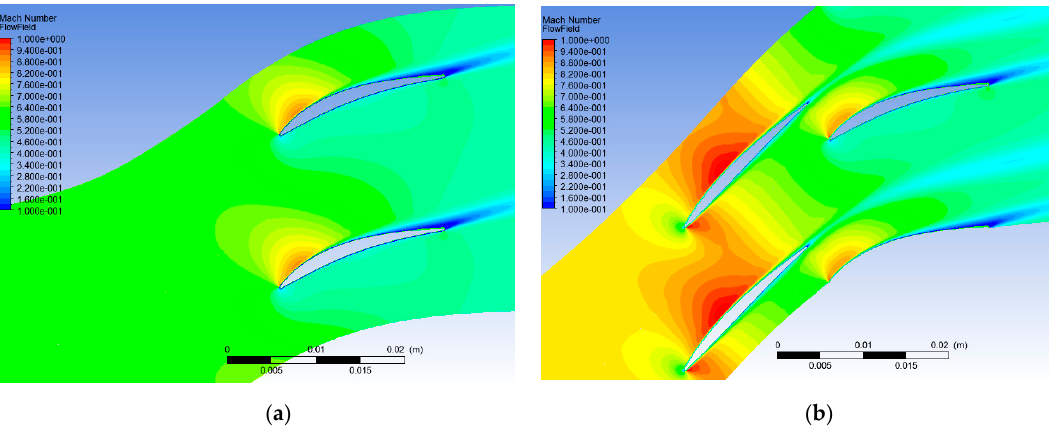
Figure 12. Comparison of Mach contours in single-blade and tandem configurations. FB incidence − 1 ◦ ; FB inflow Mach number 0.8. ( a ) AB single-blade configuration; ( b ) tandem